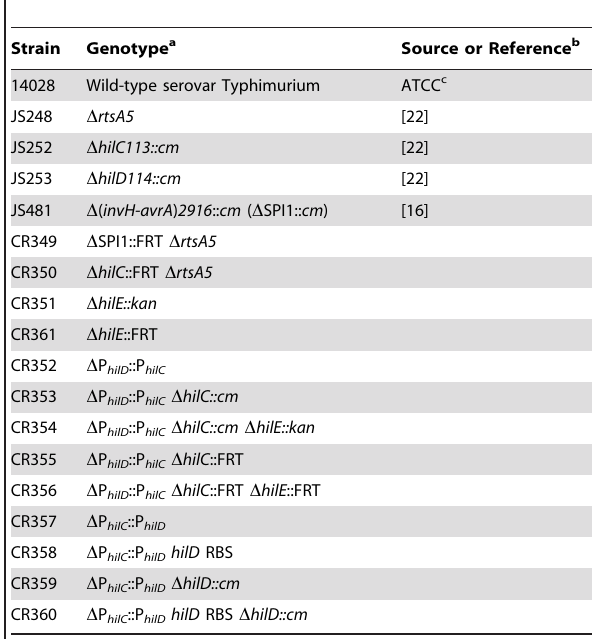
Table 1. List of strains used in this